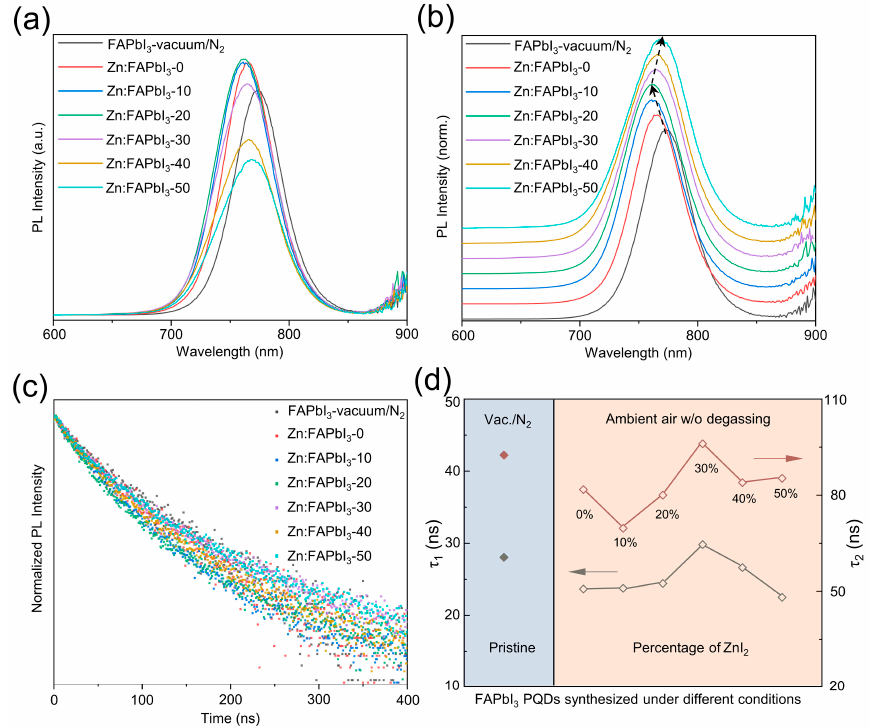
Figure 4. PL ( a ), normalized PL ( b ) spectra, and TRPL data ( c ) for the FAPbI 3 -vaccum/N 2 , Zn:FAPbI 3 - 0, Zn:FAPbI 3 -10, Zn:FAPbI 3 -20, Zn:FAPbI 3 -30, Zn:FAPbI 3 -40, and Zn:FAPbI 3 -50 PQDs. Summary of TRPL decay times ( d ) for FAPbI 3 PQDs obtained under different synthetic conditions.